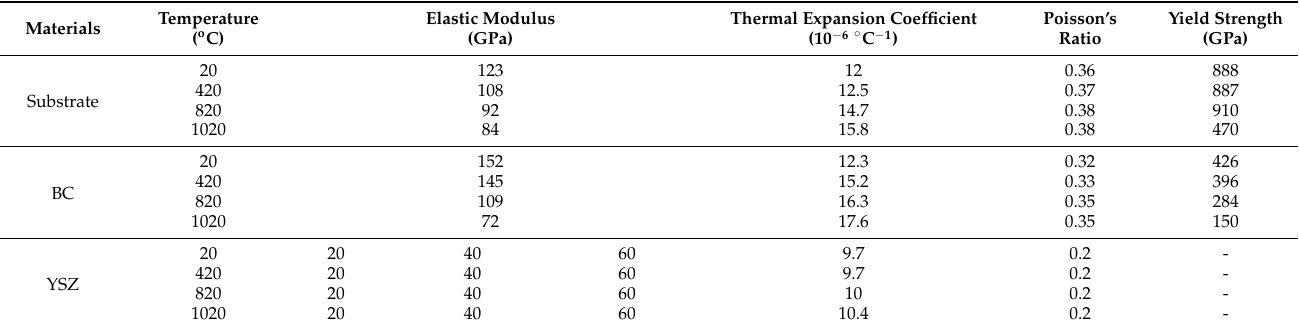
Figure 13. The geometric model, boundary conditions and meshes of the finite element model. ( a ) SEM images of cracking characteristics in the coating; ( b ) simplified model extracted from coating structure and ( c ) mesh structure and boundary conditions of the finite element model. Table 1. Temperature dependent physical properties of substrate, bond coat and YSZ topcoat.